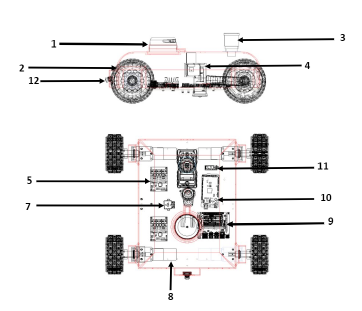
Figure 1. Mechanical Structure. 1. Lidar, 2. Magnetic Wheel, 3. Emergency Stop, 4. Thickness Probe, 5. Motor Control, 6. Thickness Gauge,7. IMU 8. Dc Motor, 9. Jetson Nano, 10. Microcontroller, 11. Bluetooth, 12.